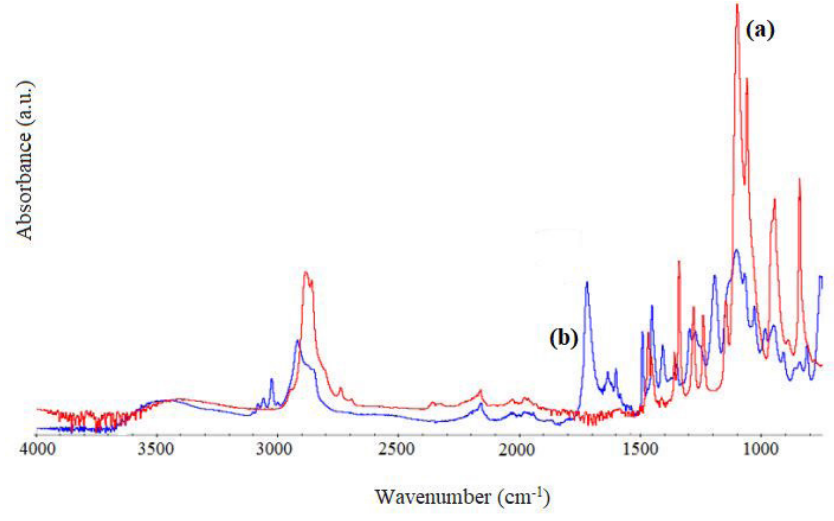
Figure 2. ATR-FTIR spectra of PGLyD (a) and CoHo:PGLyD microspheres (b).